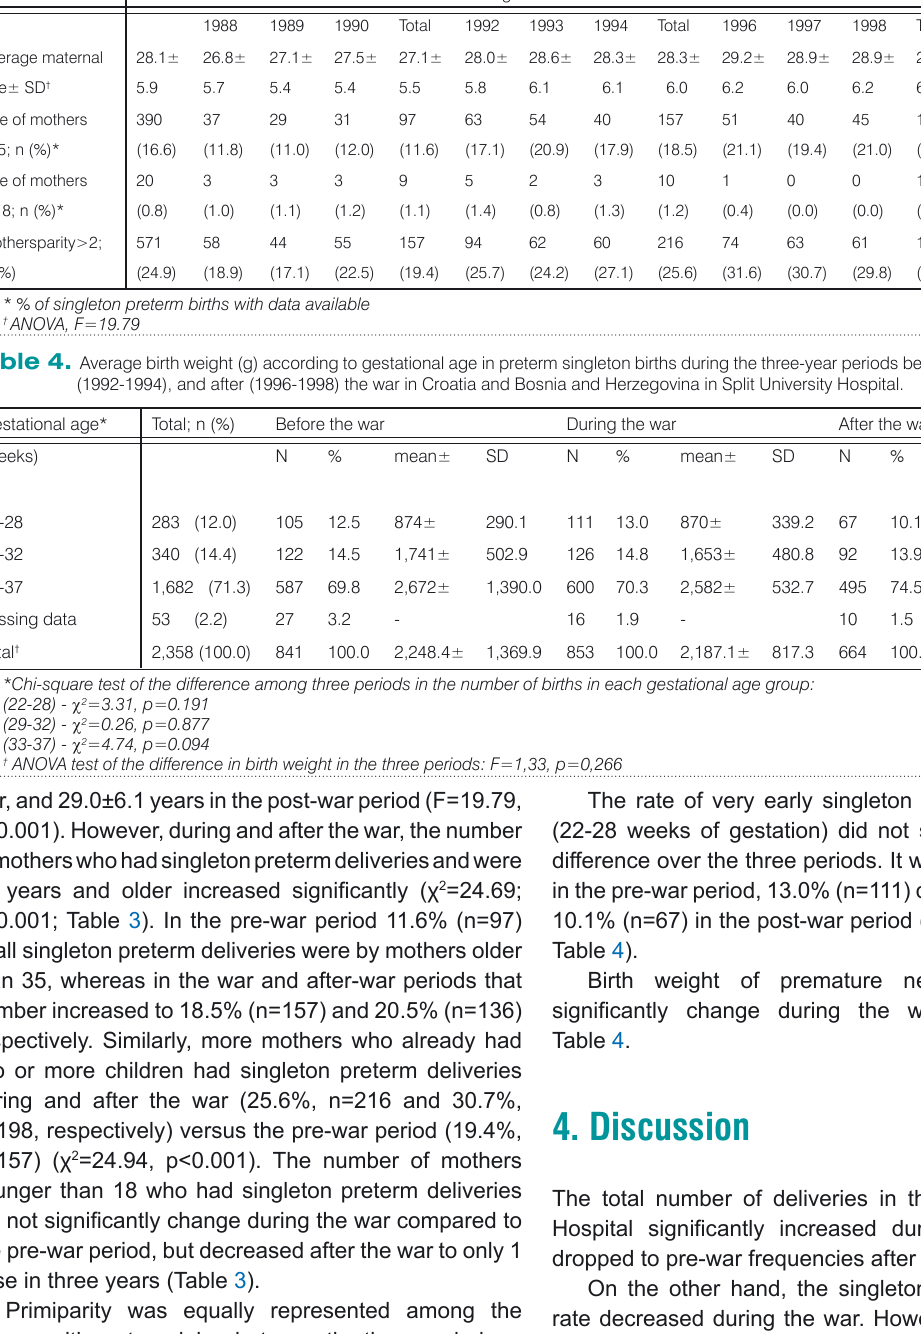
Table 3. Maternal age and parity of singleton preterm births during the three-year periods before (1988-1990), during (1992-1994), and after (1996- 1998) the war in Croatia and Bosnia and Herzegovina in Split University Hospital.